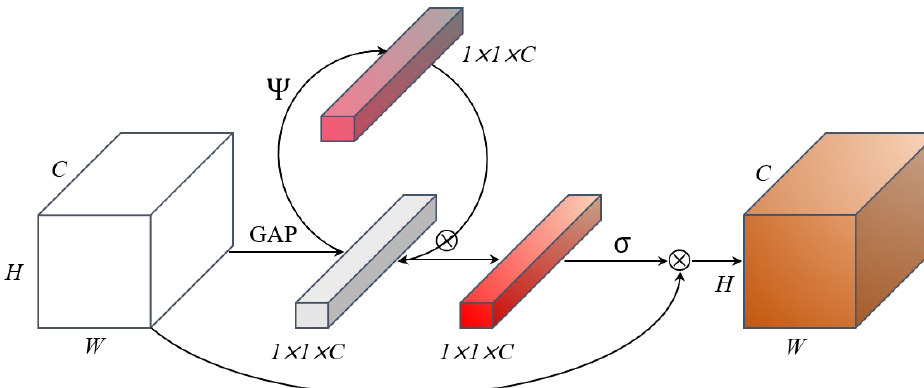
Figure 13. Schematic diagram of the self-SE module. The original feature obtains a one-dimensional vector feature after the GAP operation. The feature continues to perform a self-SE operation before being activated and is finally multiplied by the original feature.